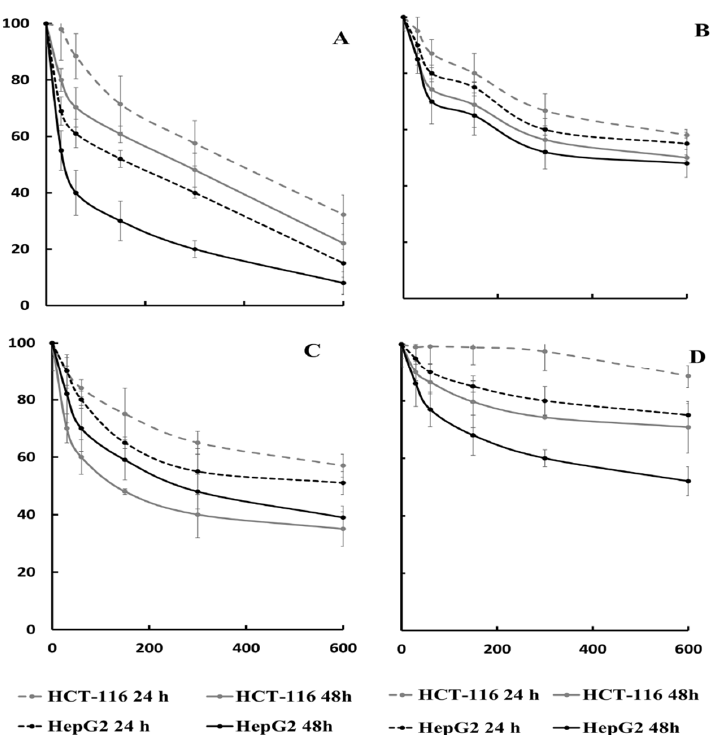
Figure 4. Cell viability assay on colon cancer (HCT-116) and human hepatocellular carcinoma